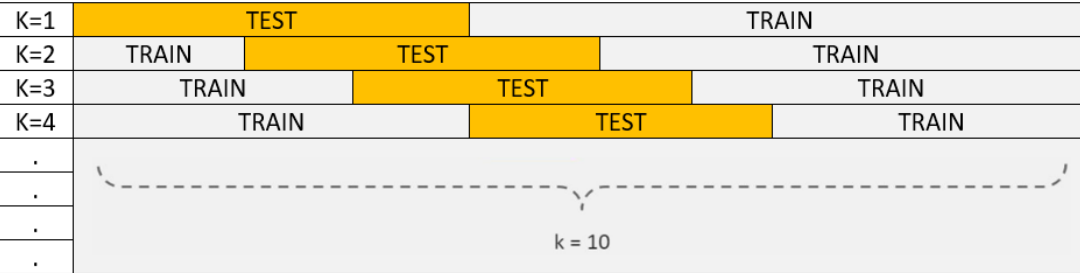
Figure 2. K-fold cross-validation